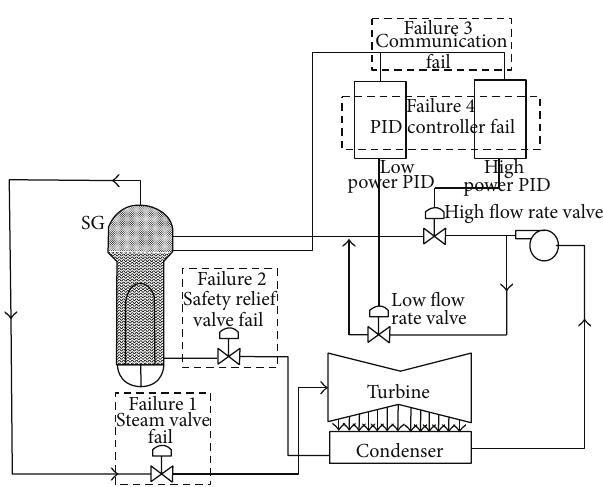
Figure 4: Sketch of the failures that can be injected into the